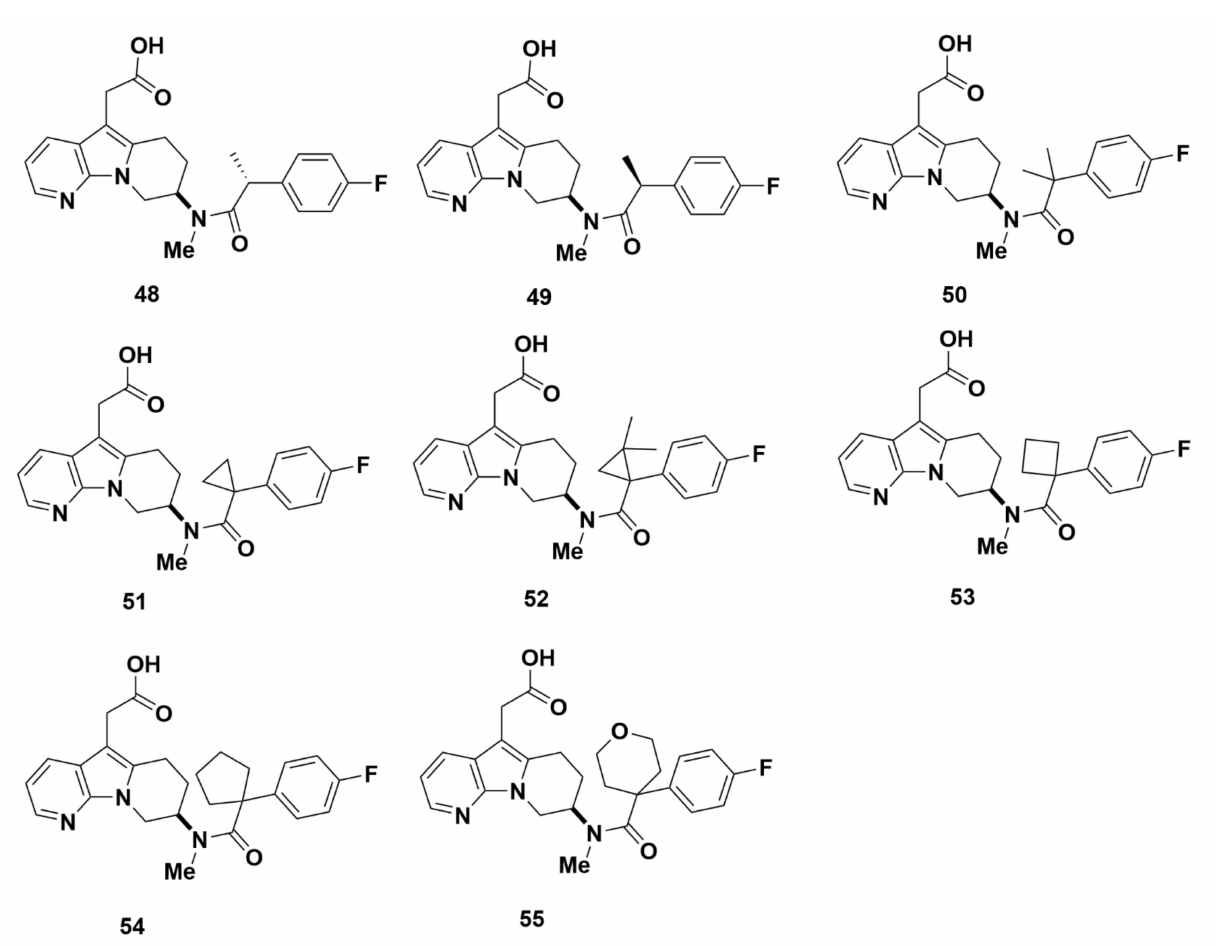
Figure 12. Molecular structures of compounds 48 – 55